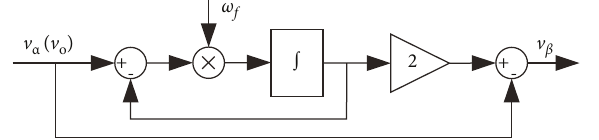
Figure 7: Structure of a first-order APF.